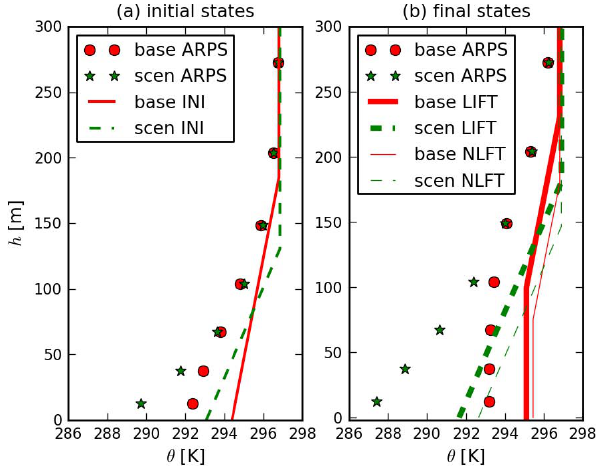
Fig. 14. The same as in Fig. 12.The horizontal and vertical wind speed for both scenarios are reduced is by a factor two in the advec- tion model. The final states of the advection model represents the temperature profile for 00:00UTC at 6.3km downwind of the city centre, because the time over the trajectory of 12.6km is increased by a factor two. These are compared with the ARPS profiles for 23:00UTC at the same